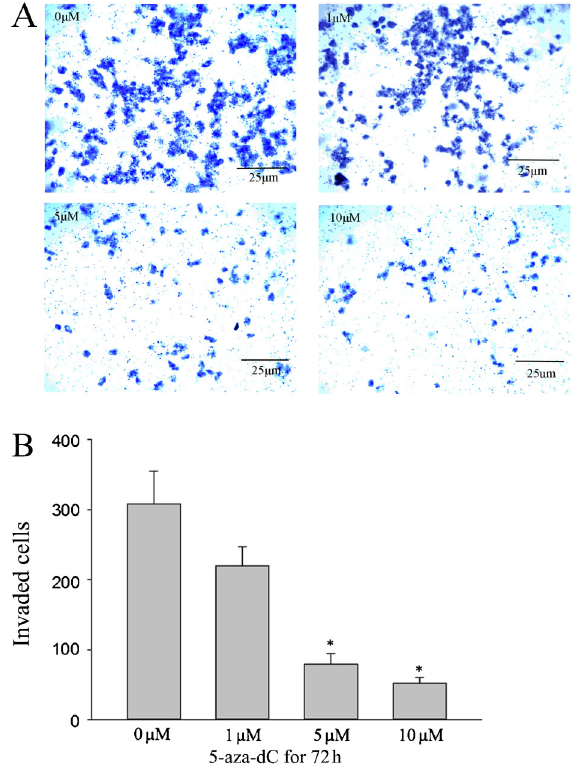
Figure 5. 5-aza-2 9 deoxycytidine (5-aza-dC) inhibited the invasion ability of ACC-M ina dose-dependentmanner. Cellswereincubated with DMSO or different doses of 5-aza-dC for 72 h. After incubation for 24 h, invaded cell numbers were counted as described previously (100 6 magnification). *P , 0.05 compared with control